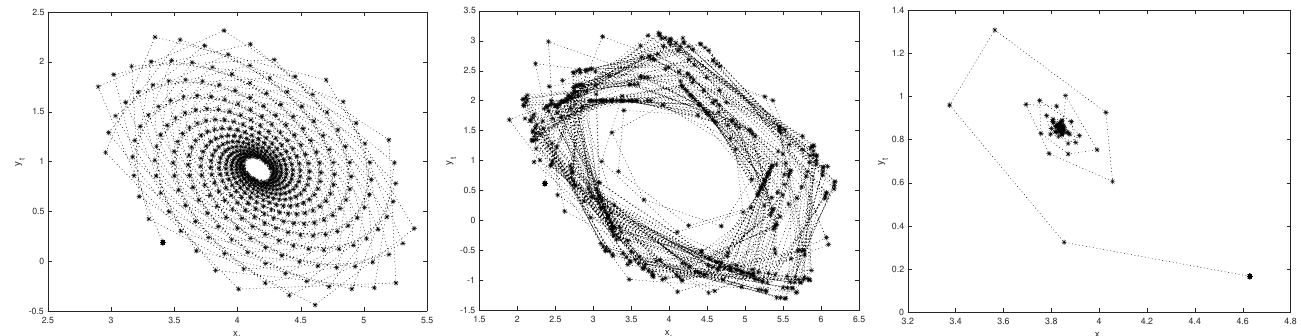
Figure 11. ( left ) shows the phase space of the fundamental map with a = 0.8, b = 0.9 and c = 1.1, ( middle ) shows the phase space of fundamental and chartist map with a = 0.8, b = 0.9 and c = 1.1 and e = 2.0, and ( right ) shows the phase space of the complete map with the same values of previous plot and d m = 0.5.